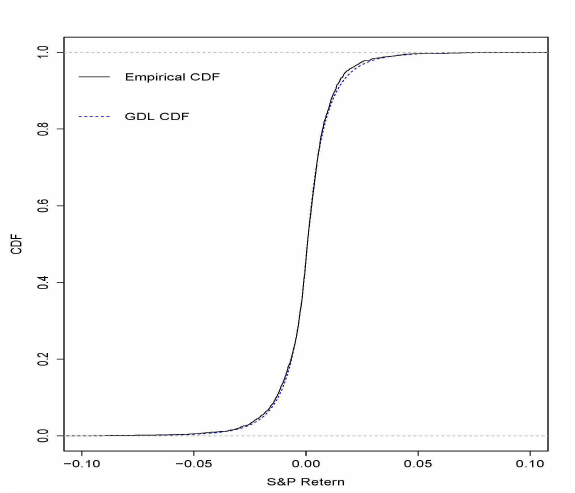
Figure 3 –: CDF’s of Empirical and fitted GDL of SP500. Empirical cumulative distribution function (solid) of the daily returns on the SP 500 index compared with GDL cumulative distribution function using MLE